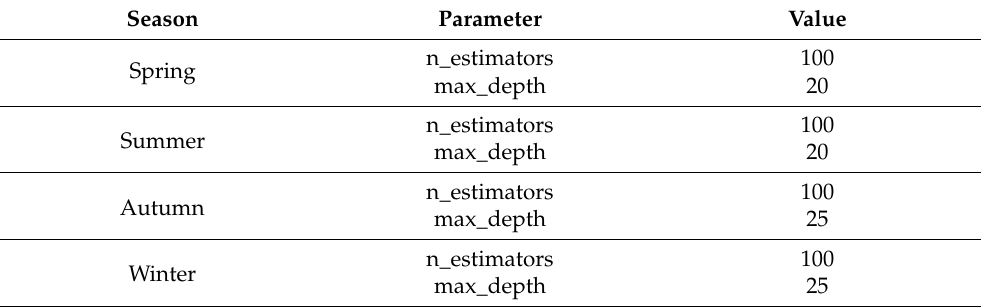
Table 3. Optimal hyperparameters for the seasonal models.